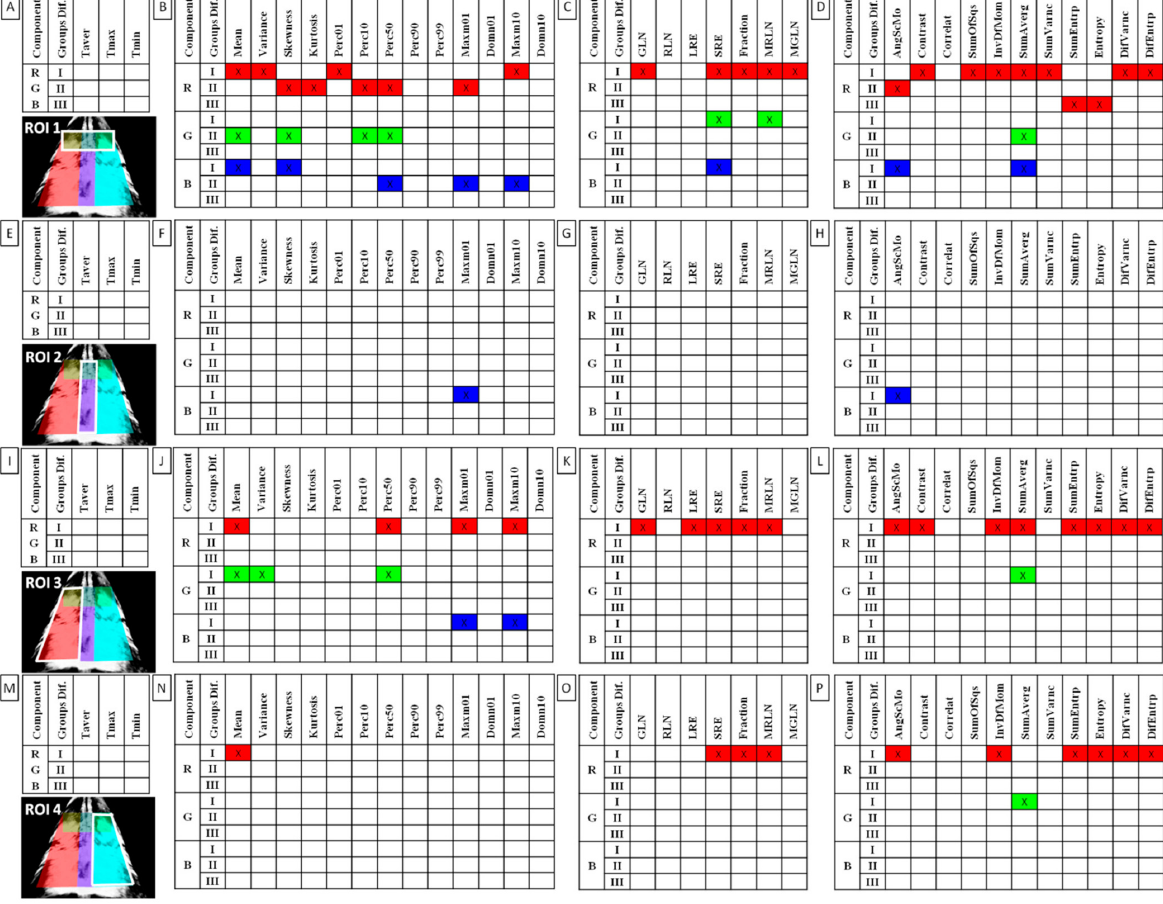
Figure 4. Features of ( A , E , I , M ) conventional thermography, ( B , F , J , N ) histogram statistics, ( C , G , K , Q ) gray-level run-length matrix and ( D , H , L , P ) gray level co-occurrence matrix for